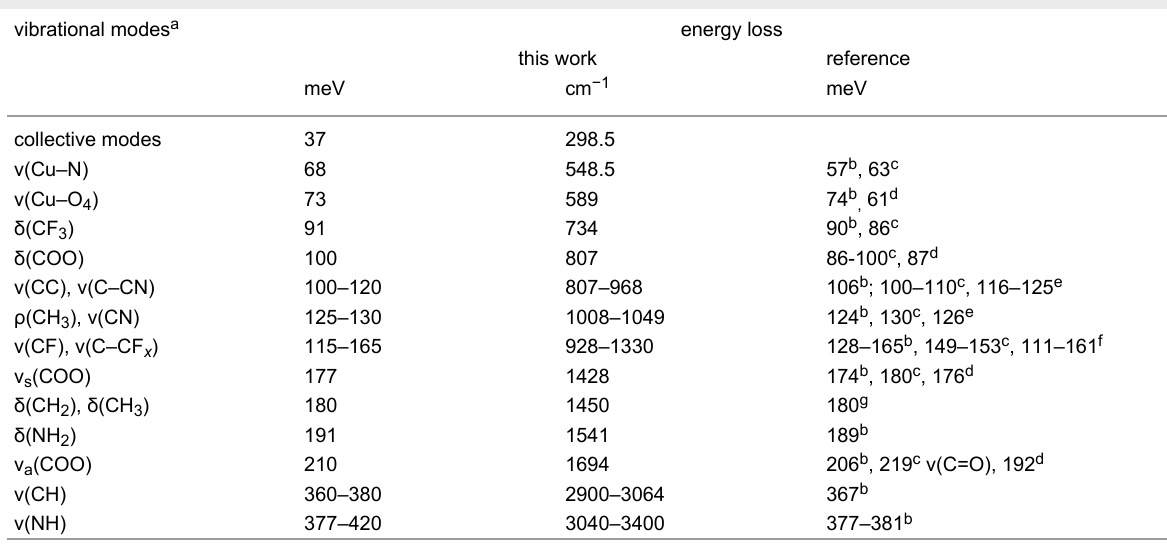
Table 1: HREELS vibrational signature